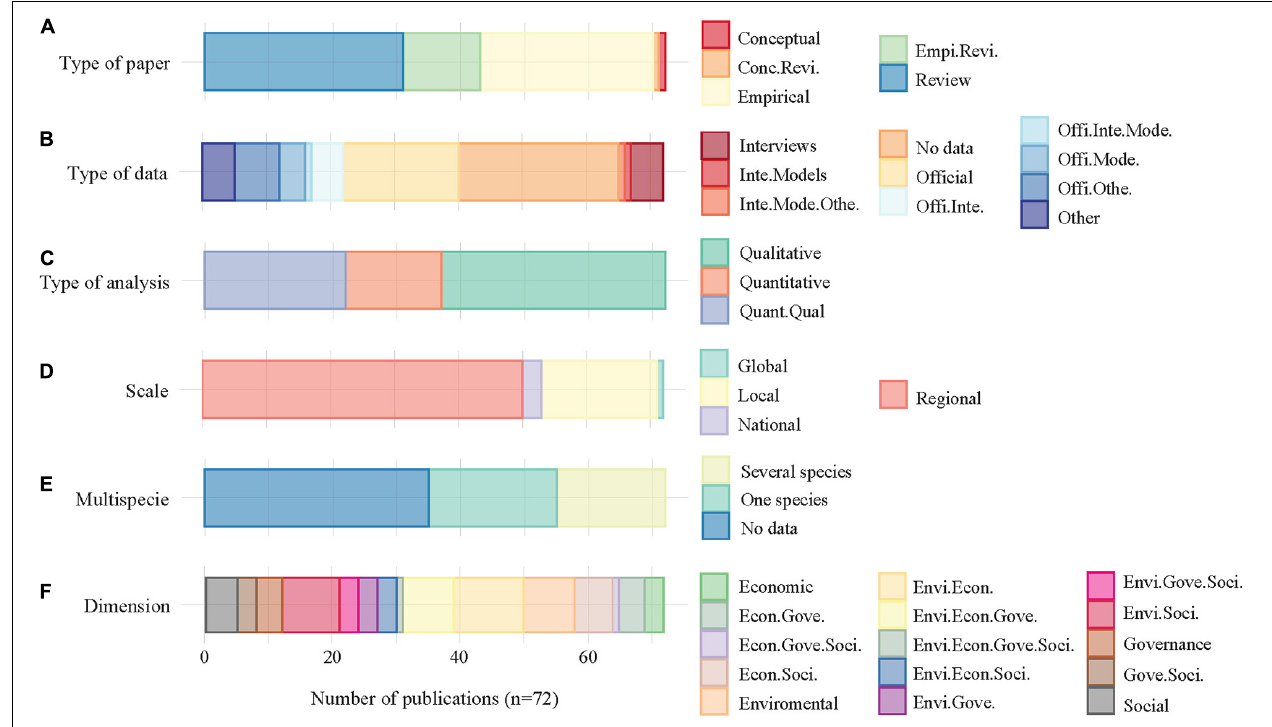
FIGURE 4 | Publications ( n = 72) analyzed from 1990 to 2020 in relation to small-scale fisheries in Galicia, according to the type of publication (A) , type of data used (B) , type of analysis (C) , scale (D) , species studied (E) , and dimension (F).